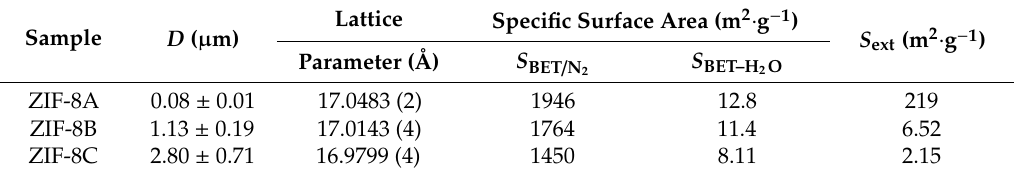
Table 1. Structural and microstructural data for the prepared zeolitic imidazolate framework-8 (ZIF-8) materials.